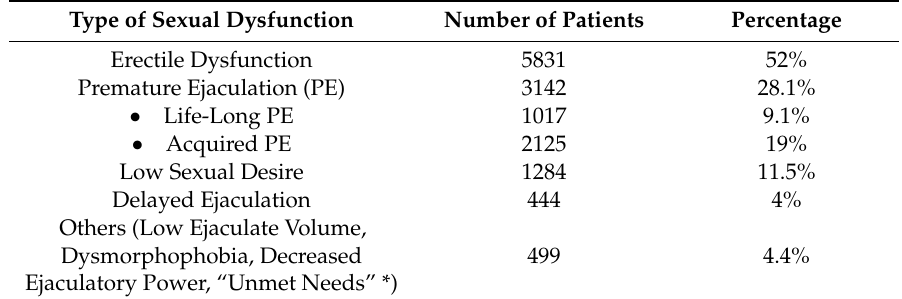
Table 1. Prevalence of the symptoms that brought the patients to look for andrological consultation.